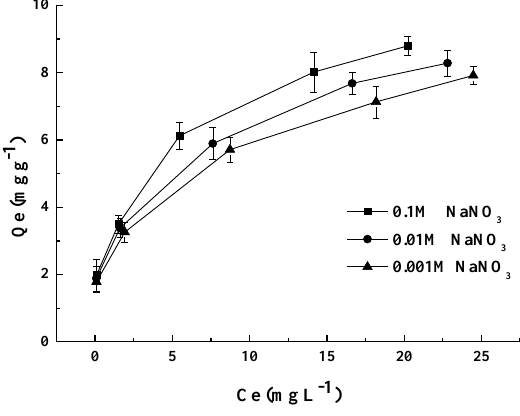
Figure 8. The effect of solution on adsorption by FMCBC 3 .